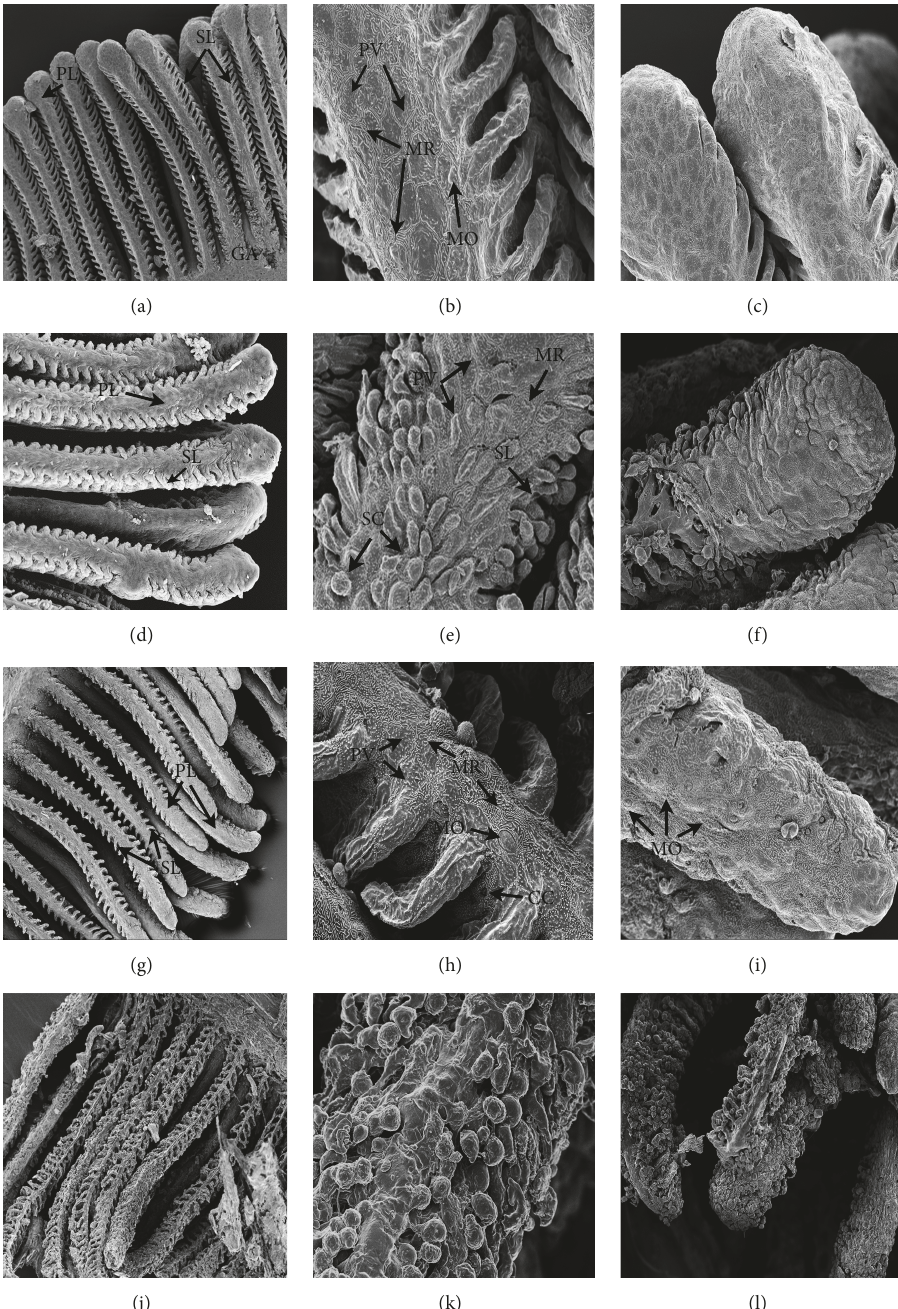
Figure 1: Gill filaments histological sections of Cnesterodon decemmaculatus exposed to different treatments for 96 h. Treatments: NC (negative control, MHW); RR (surface water of the Reconquista River); RR+Cd (surface water of the Reconquista River with 2 mg Cd/L); Cd (2 mg Cd/L). Photomicrographs were taken under a Philips XL series 30 or a Carl Zeiss NTS SUPRA 40 scanning electron microscope. Slides (a), (b), and (c) correspond to fish exposed to NC: (a) normal arrangement of primary lamellae (PL) and secondary lamellae (SL) on the gill arc (GA) (350 X); (b) enlarged portion of (a): pavement cell (PV), concentric microridge (MR); mucous cell (MO) (3500X); (c) apical portion of a PL (2000X). Slides (d), (e), and (f) correspond to fish exposed to Cd: (d) primary (PL) and secondary lamellae (SL) (200 X); (e) aspect of a portion of PL with its SL, evident heeling (SC), and disorganization of the epithelium (3500X); (f) apical portion of a PL, showing epithelium disorganization, lifting and swelling of the pavement cells (2000X). Slides (g), (h), and (i) correspond to fish exposed to RR: (g) primary (PL) and secondary lamellae (SL) (350 X); (h) enlarged portion of a PL showing pavement cell (PV), concentric microridge (MR), mucous cell (MO), and chloride cell (CC) (4000X); (i) apical portion of a PL showing edema and abundant mucous cells (MO) flanked by pavement cells (3000X). Slides (j), (k), and (l) correspond to fish exposed to RR+Cd: (j) primary (PL) and secondary lamellae (SL) (500 X), (k) enlarged portion of a PL showing marked epithelium disorganization (5000X); (l) apical portion of a PL showing different degrees of epithelium disorganization, varying from edema to complete disorganization of epithelial architecture